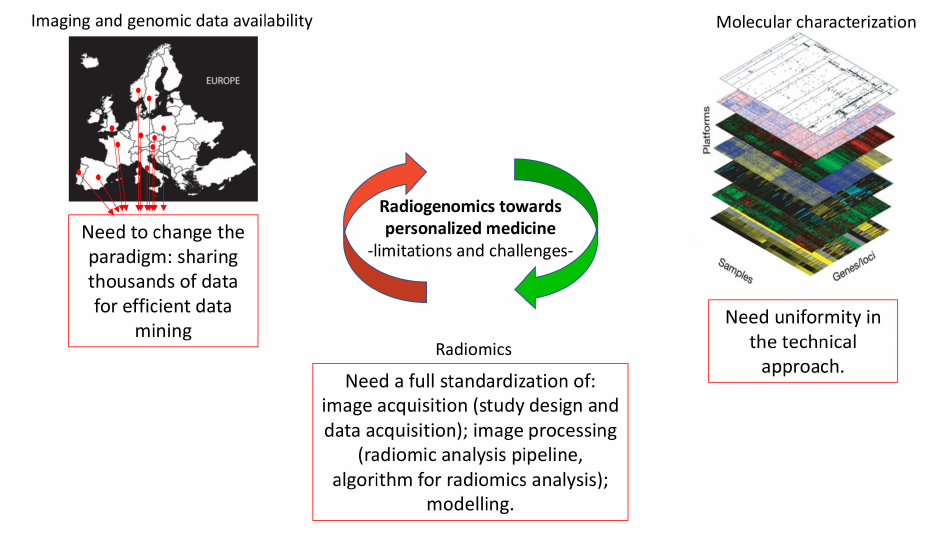
Figure 2. Limitations and challenges of radiogenomic